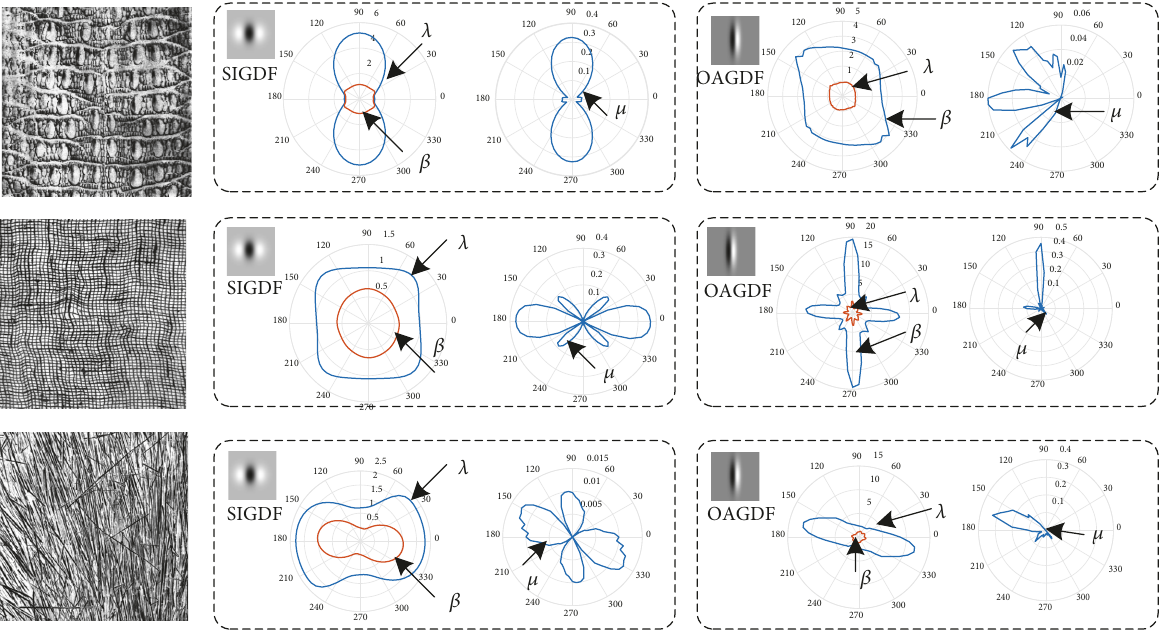
Figure 7: SWDM-based omnidirectional texture image